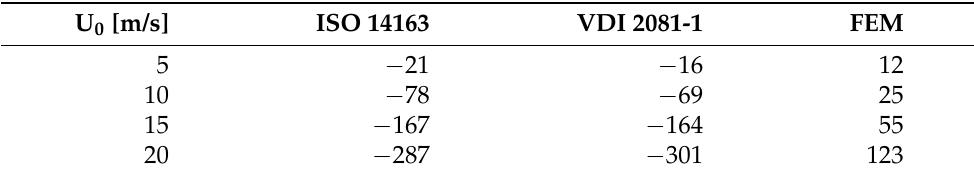
Table 6. Difference between the predicted pressure loss (in Pascals) obtained with ISO 14163, VDI 2081-1 and FEM with that of experimental measurements for the system of splitters with semihexadecagonal